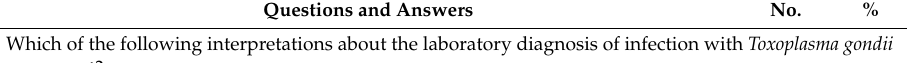
Table 3. Knowledge of diagnosis and treatment of toxoplasmosis.